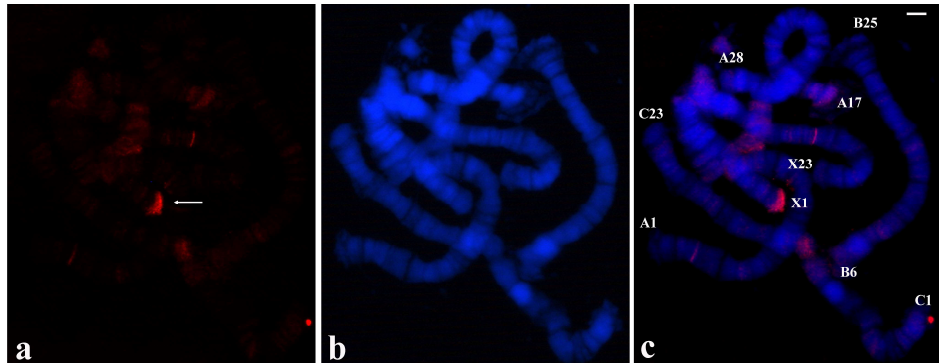
Figure 4. ( a ) Polytene chromosomes of T. pubescens after in situ hybridization (red signal) using the probe made of DNA from the microdissected X-1 chromosome end of T. pubescens. The arrow points to the main hybridization signal at the chromosome end X-1. ( b ) The same chromosomes stained with DAPI and ( c ) the merged signals. Bar = 15 µ